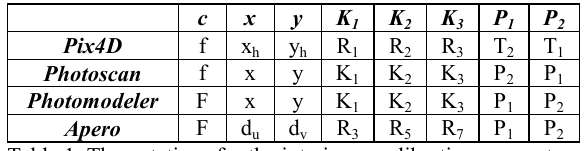
Table 1. The notations for the interior or calibration parameters in the software solutions used in this